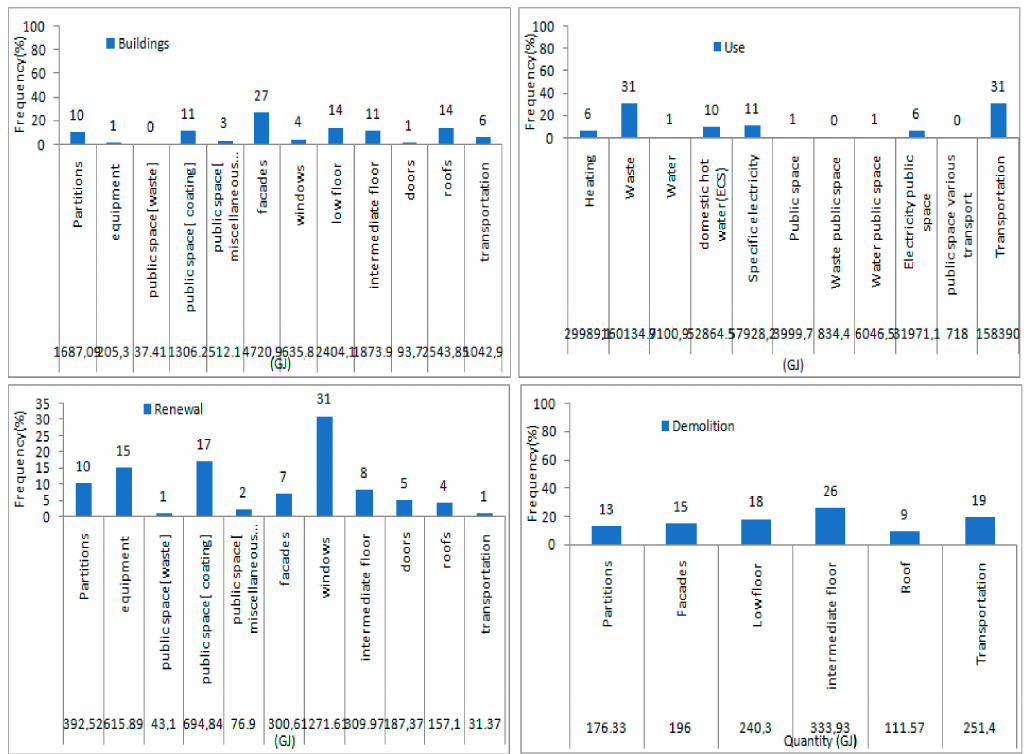
Figure 7. Detailed results of the “cumulative energy demand” impact calculation at the neighborhood scale (initial